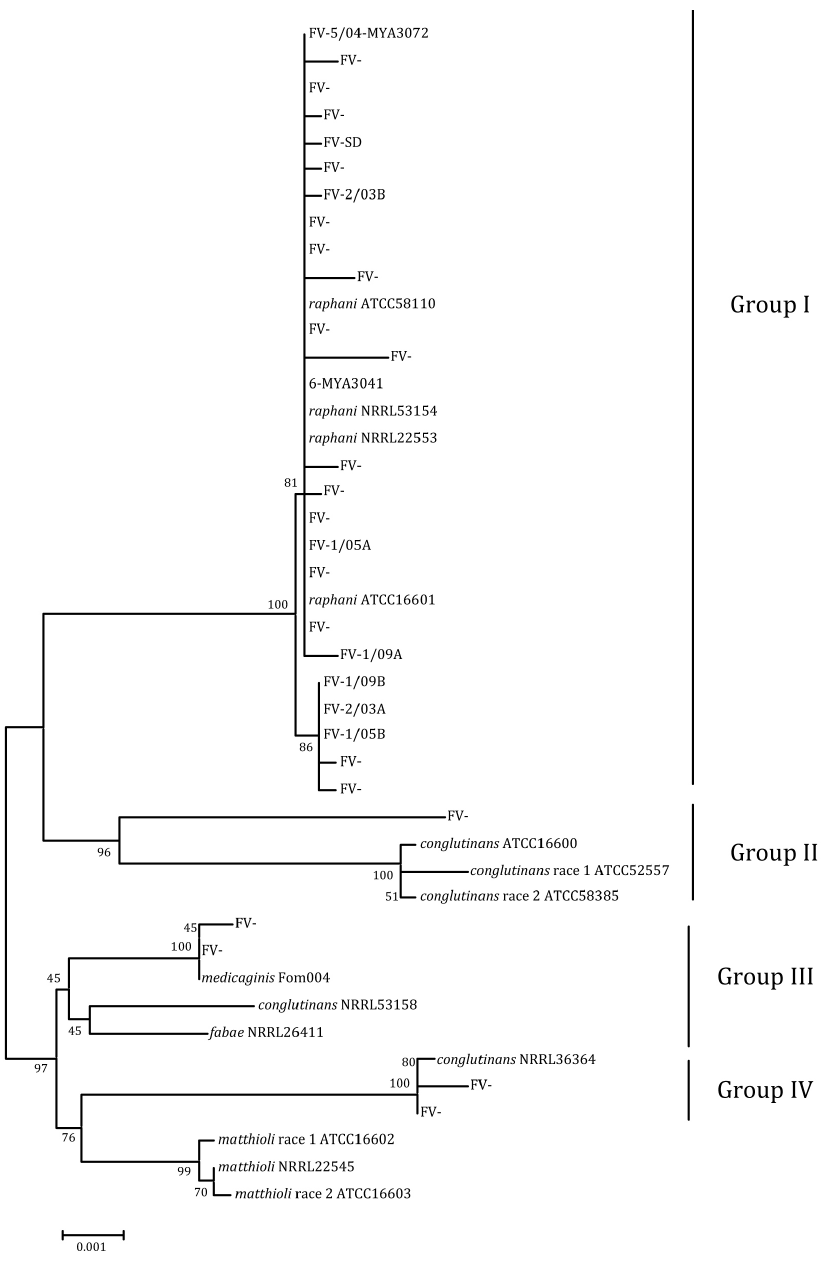
Figure 1. Phylogenetic relationships of 44 isolates (%). The evolutionary history was inferred using the neighbour- joining method. The optimal tree with the sum of branch lengths = 0.0429 is shown. The percentages of replicate trees in which the associated taxa were clustered together in the bootstrap test (10000 replicates) are shown next to the branches. The tree is drawn to scale, with branch lengths in the same units as those of the evolutionary distances used to infer the tree. Evolutionary distances were computed using the Maximum Composite Likelihood method and are in the units of the number of base substitutions per site. All positions containing gaps and missing data were eliminated from the dataset (Complete delete option). There was a total of 1971 positions in the final dataset. Phylo- genetic analyses were conducted using